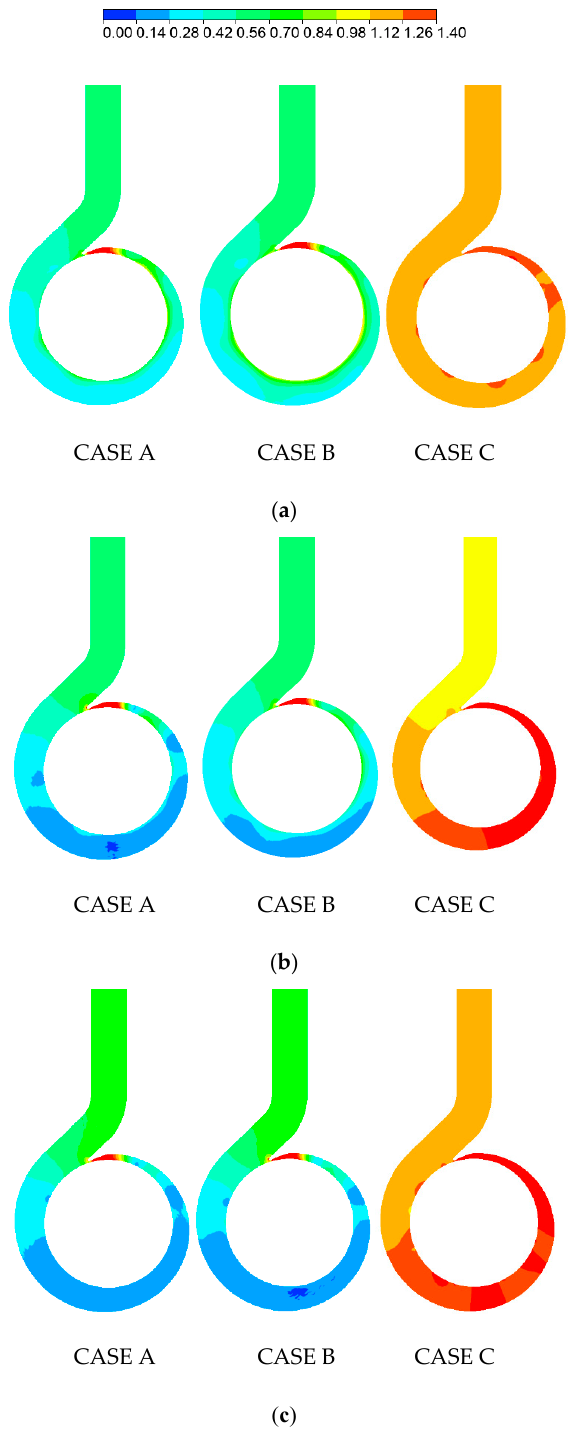
Figure 12. Pressure distribution within the volute of the optimized cases A, B and C under flow conditions of: ( a ) 1.0 Q d ( b ) 1.2 Q d and ( c ) 1.4 Q d